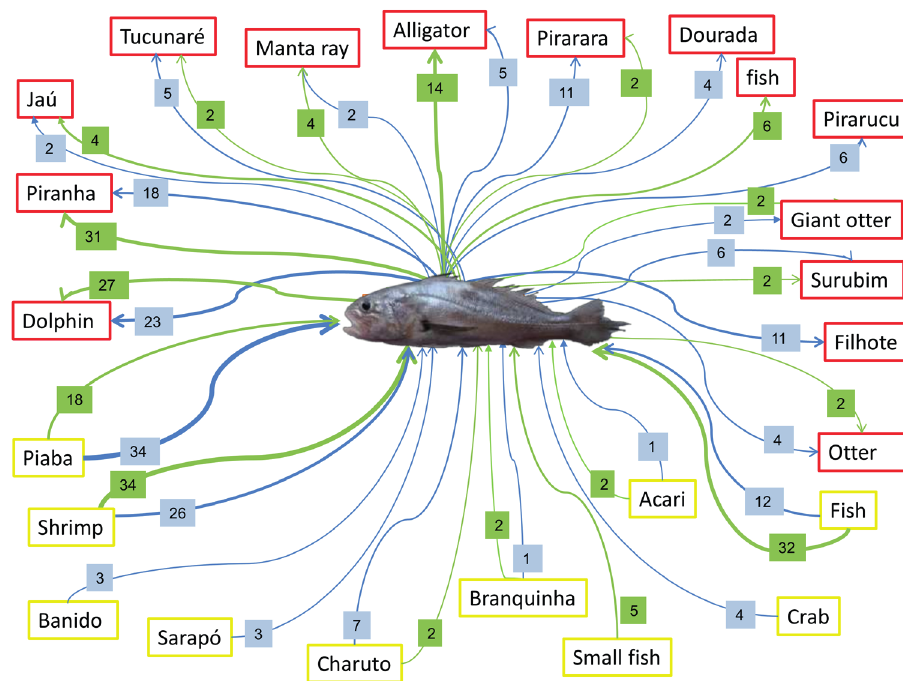
FIGURE 5 | Diagram depicting the main trophic interactions (simplified food web) of Plagioscion squamosissimus based on fishers’ LEK (interviews) indicating the 10 most cited prey (yellow) and the 14 most cited predators (red), in the Tapajós (blue) and Tocantins (green). Numbers inside squares are the percent of citations of prey and predators of P. squamosissimus by the interviewed fishers. We obtained 150 citations of prey and 129 citations of predators by the interviewed fishers in the Tapajós River and 56 citations of prey and 50 citations of predators in the Tocantins River. Line thicknesses indicate the number of citations by the fishers